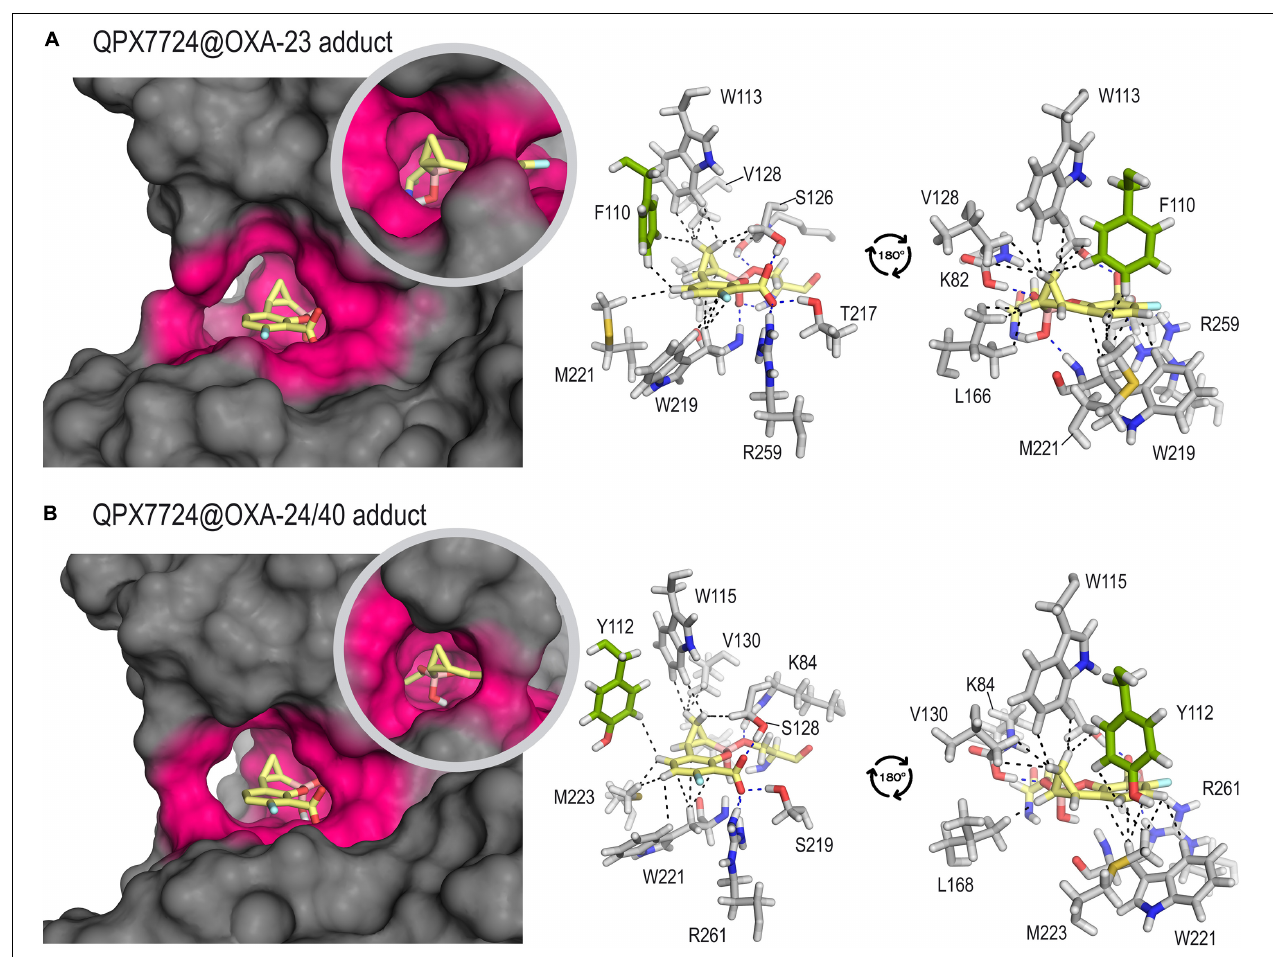
FIGURE 4 | Inactivation of OXA-23 (A) and OXA-24/40 (B) by QPX7728 obtained by MD simulation studies. Overall and detailed views are provided. Snapshots taken after 90 ns of simulation are shown. Relevant side chain residues are shown and labeled. The enzyme area surrounding the adduct is highlighted in pink. Key polar (hydrogen bonding and electrostatic, blue) and CH- π and apolar interactions (black) are shown as dashed lines. Note the high amino acid sequence similarity of the active site residues in close contact with the modified inhibitor for both adducts. The main sequence difference is residue F110 (OXA-23) that is replaced by Y112 in OXA-24/40, both showed in